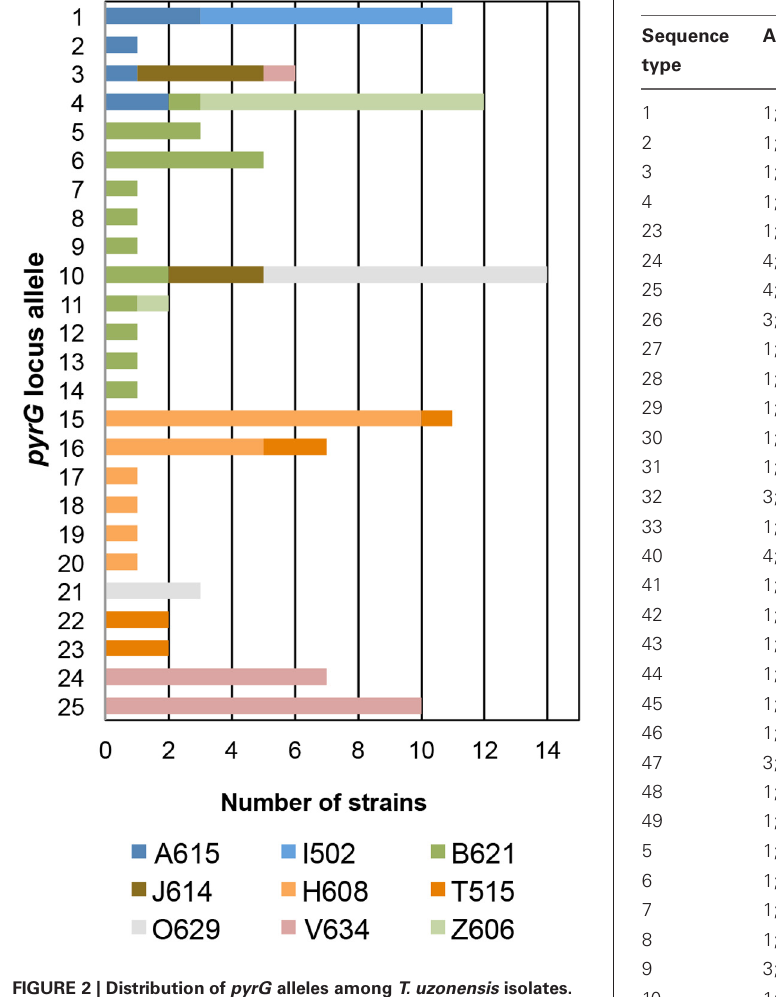
Table 6 | Summary of T. uzonensis sequence